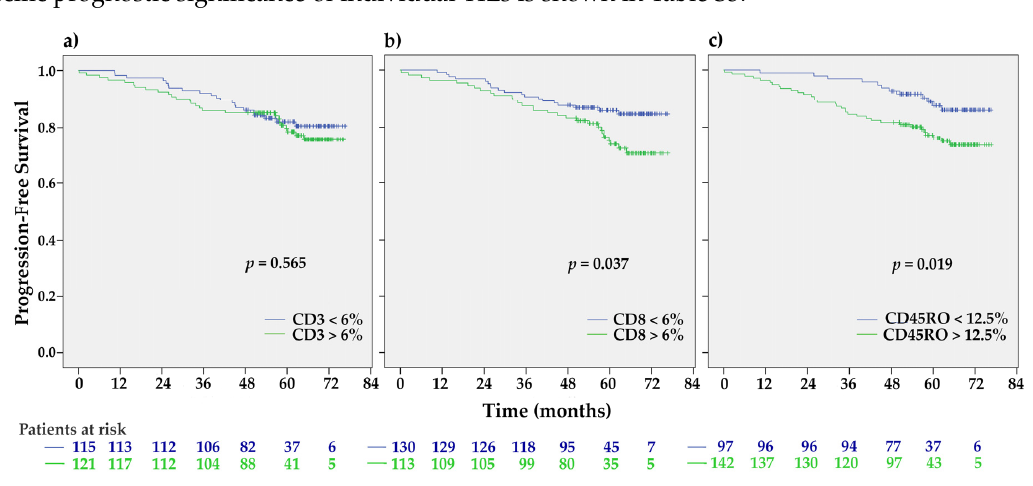
Figure 2. The Kaplan-Meier progression-free survival (PFS) estimates for studied stromal TILs expression. In contrast to patients with CD3 infiltration ( a ) those with CD8 high ( b ) and CD45RO high ( c ) had significantly shorter PFS than those with CD8 low or CD45 low , respectively ( p = 0.037 and p = 0.019 by the Log-rank test).